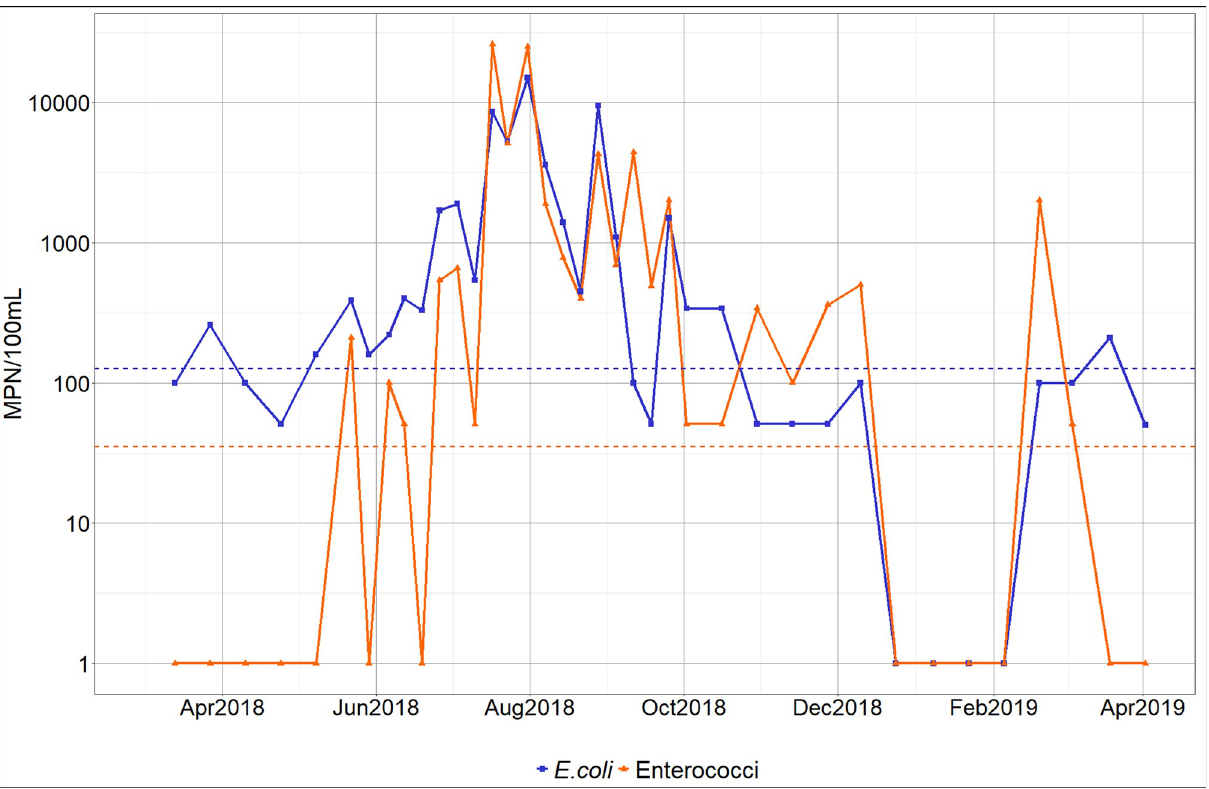
Fig 4. Temporal dynamics of E . coli and enterococci at the Kapore site (horizontal dotted lines correspond to USEPA 2012 bathing water quality standard: dotted lines in orange and blue show the limit for enterococci and E . coli , respectively).